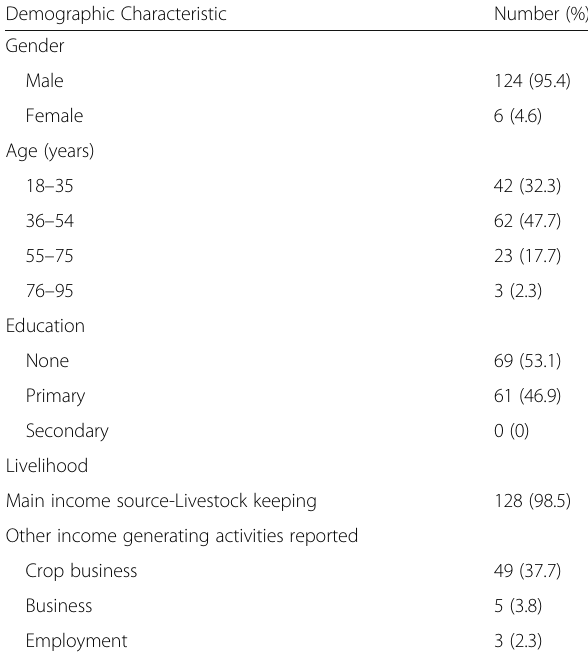
Table 1 Demographic characteristics of cattle owners ( N = 130) surveyed in 10 villages in Monduli District, Northern Tanzania in 2015